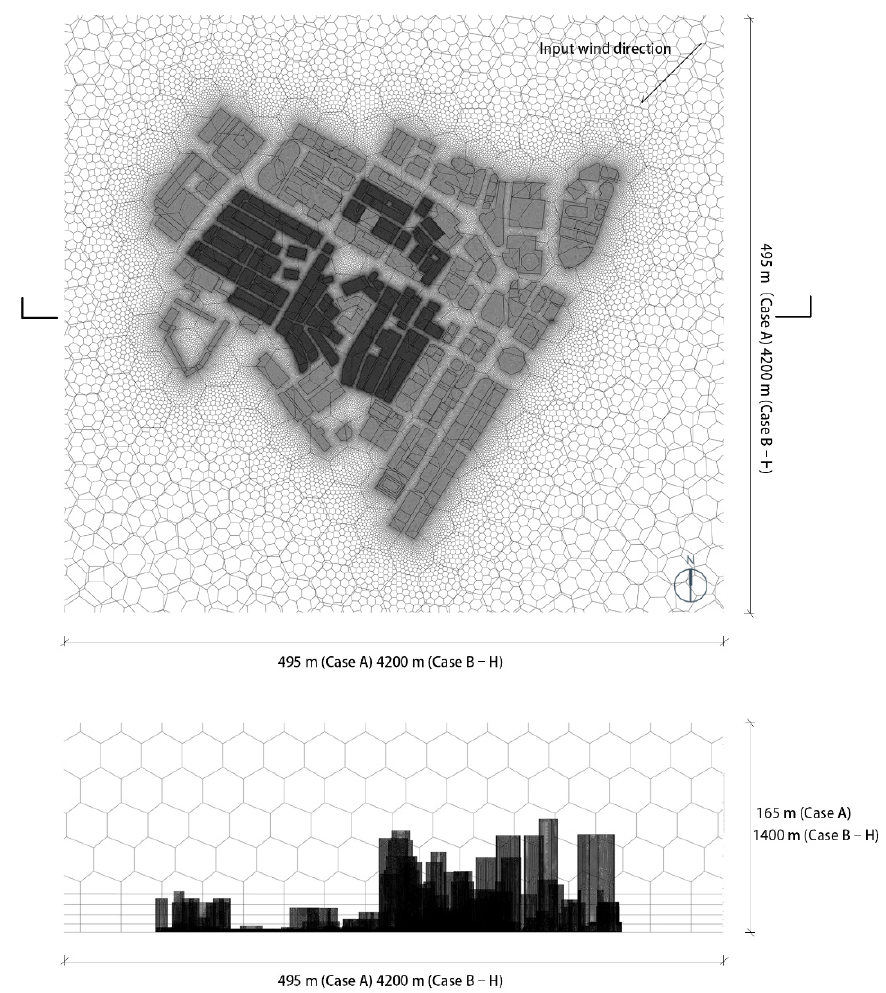
Figure 3. Horizontal and vertical cross-sections of the computational domain of Case B as an example to present domain size, meshing, and input wind direction.